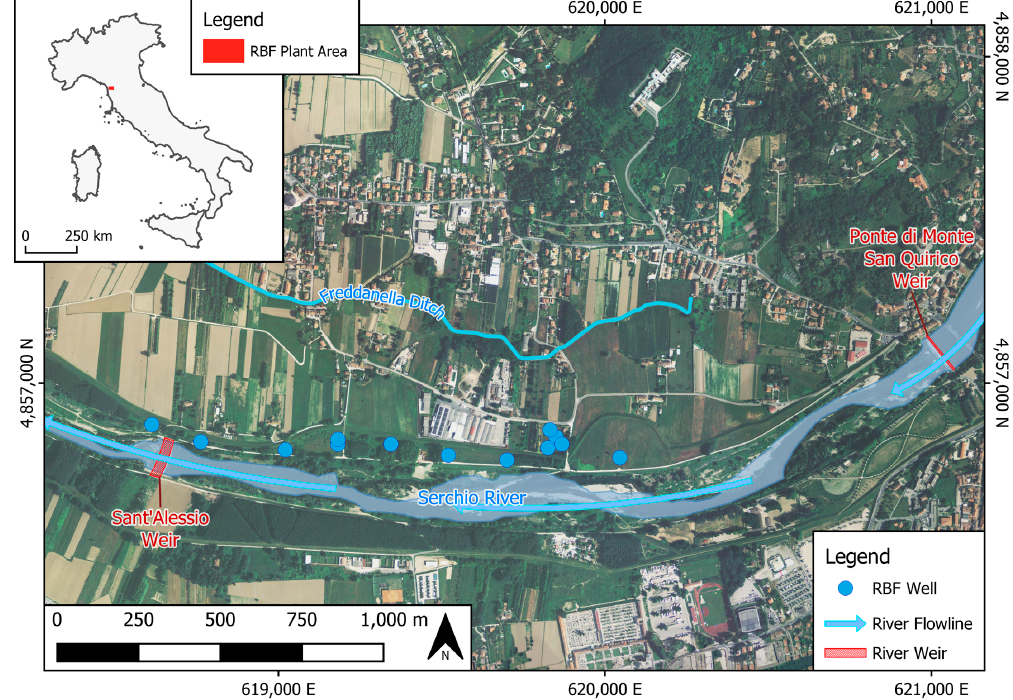
Hydrology 2020 , 7 , x FOR PEER REVIEW 4 of 21 Figure 1. Layout of the Serchio River riverbank filtration scheme in Lucca, Italy. Coordinates are in WGS84-UTM zone 32N (EPSGr: 32632).